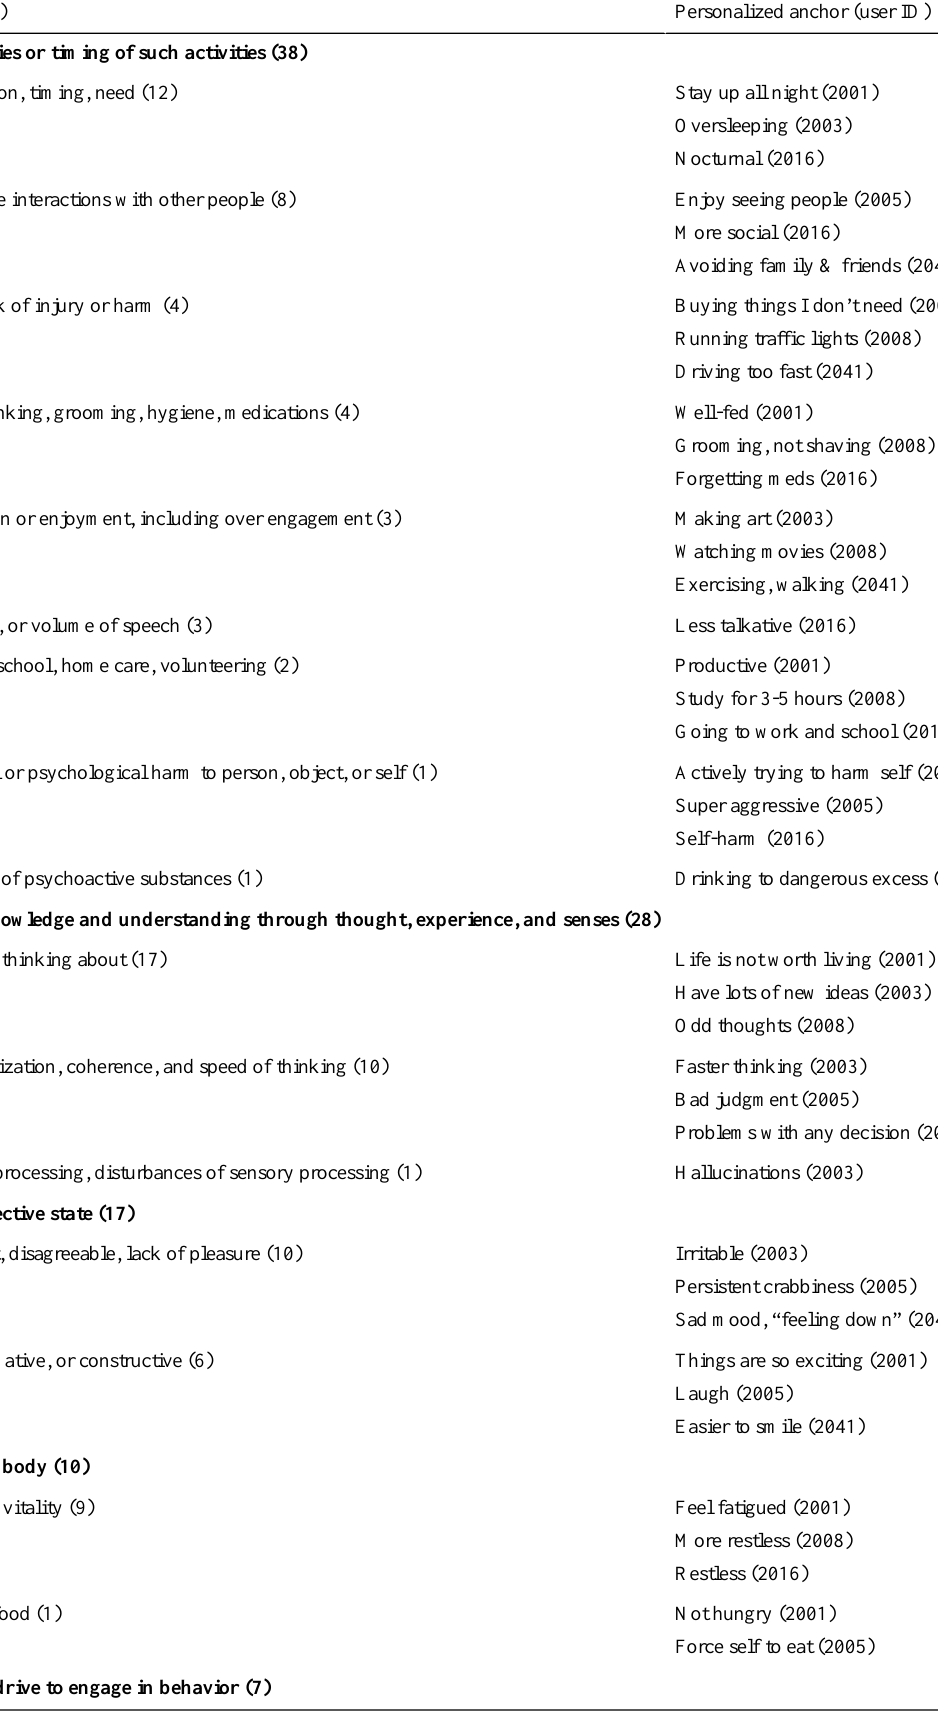
Table 7. Pilot study: thematic analysis of personalized wellness rating scale anchors